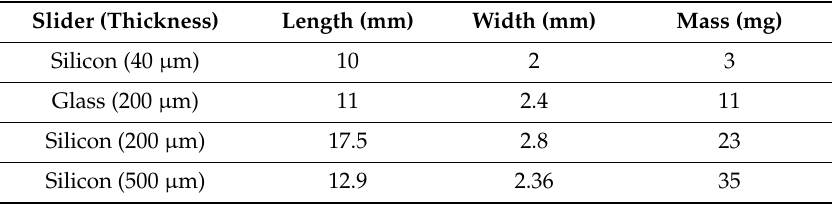
Table 7. Sliders used in the di ff erent kinetic studies of the